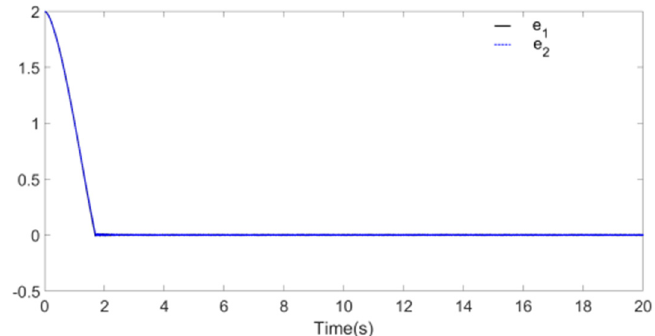
y y arrives arrives y x arrives 2 .